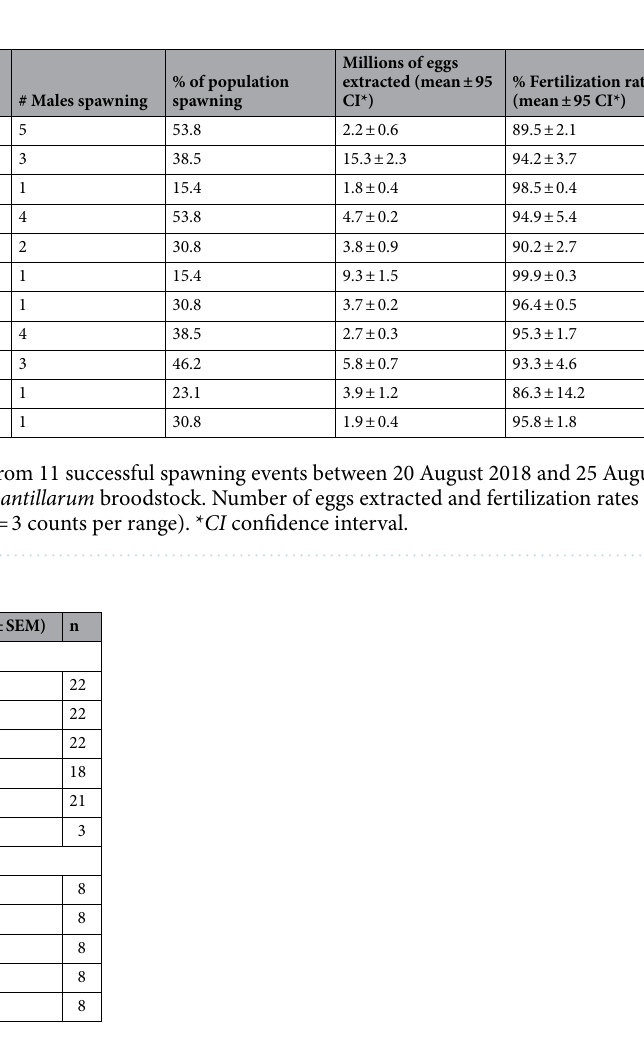
Table 2. Mean ± SE water quality parameters monitored throughout the larval culture period. SEM Standard error of the mean. a Reported as CaCO 3 . b Total organic carbon.